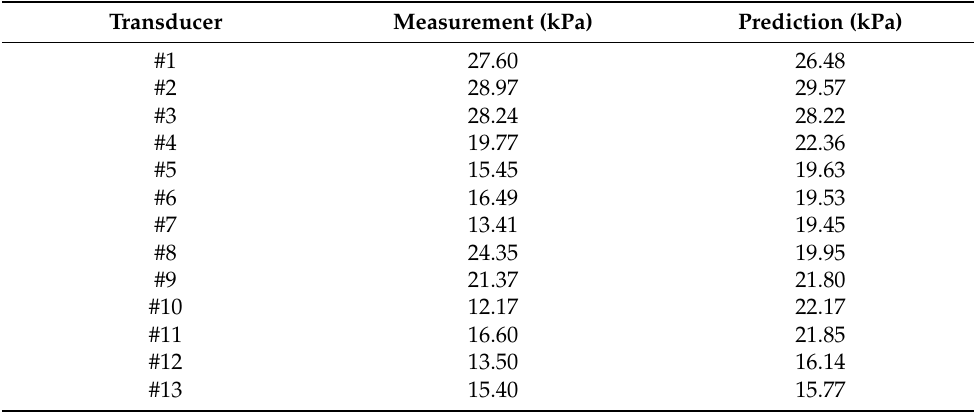
Table 3. Measurement ( P 1/10 ) and prediction ( H 1/10 , T 1/10 ).